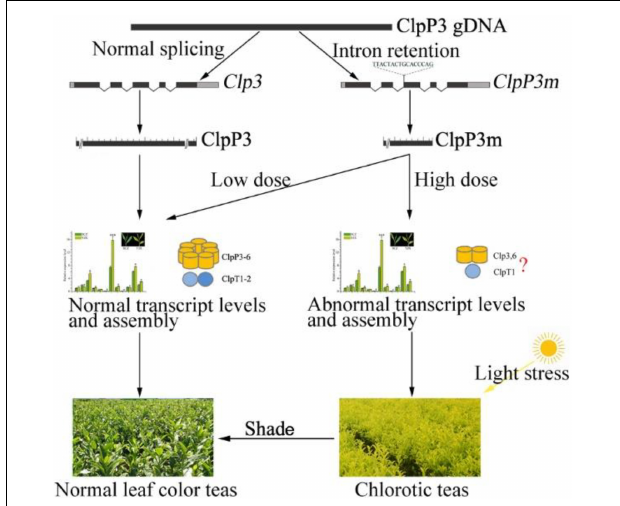
FIGURE 7 | Schematic diagram of the possible mechanism for dose-dependency of ClpP3m in tea leaf chlorosis. The normal Clp complex assembly is adapted from Nishimura and Van Wijk (2015). Abnormal assembly with a red question mark indicates that it was a hypothesis of the